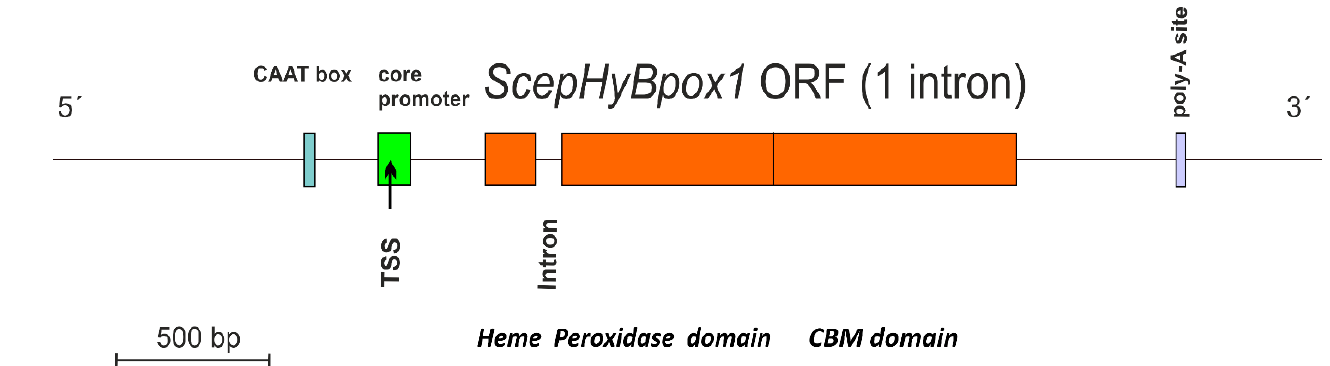
Figure 1. Gene architecture of ScepHyBpox1 with detection of core promoter region (green), CAAT box (blue), and poly-A site (violet). TSS—transcription start site. The border between regions coding for two separate domains is labelled and drawn to scale according to predictions from FGENESH 2.6.